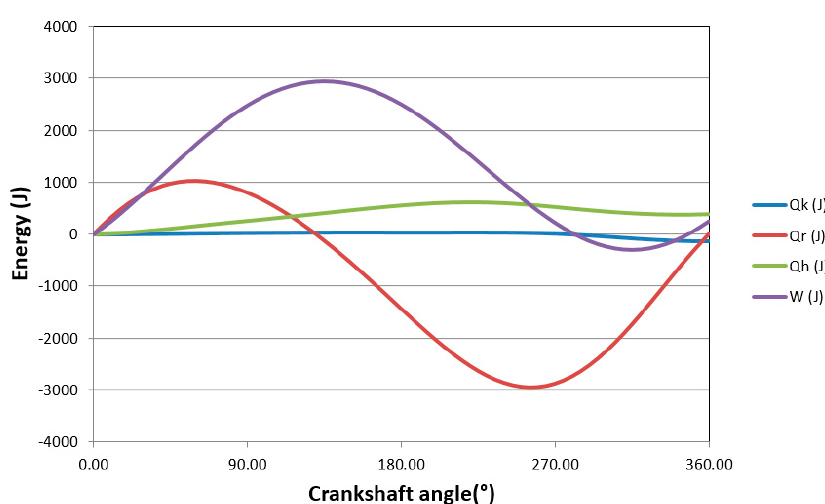
Figure 6. Energy change during one cycle.